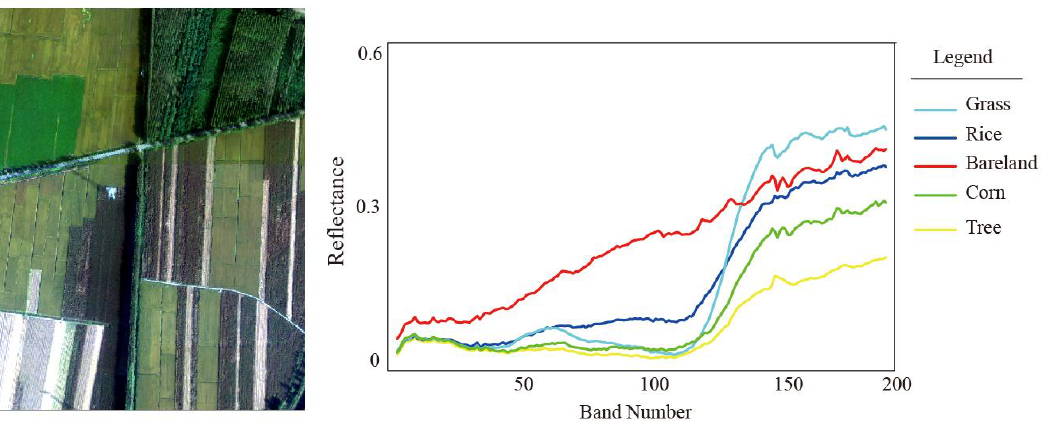
Figure 5. The Shenyang dataset shown in RGB format as well as GT endmembers.